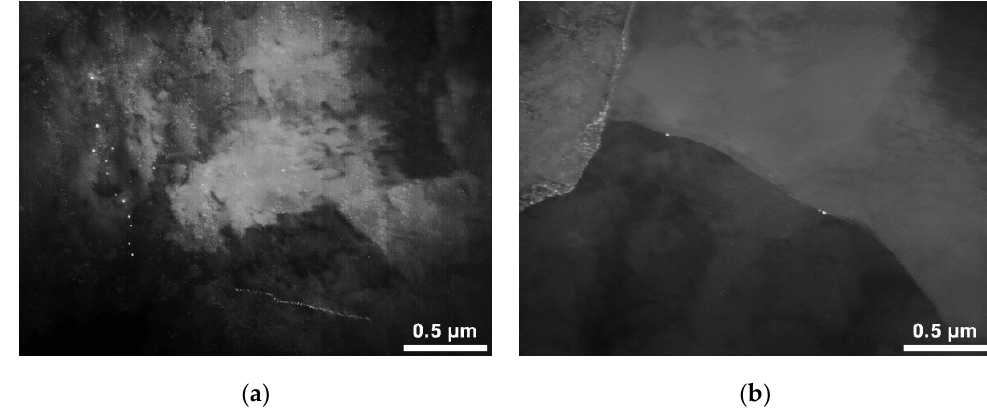
Figure 6. Dark-field image in the reflections of nanosized carbonitrides (steel No 2): ( a ) In the grain body; ( b ) Along the grain boundaries.